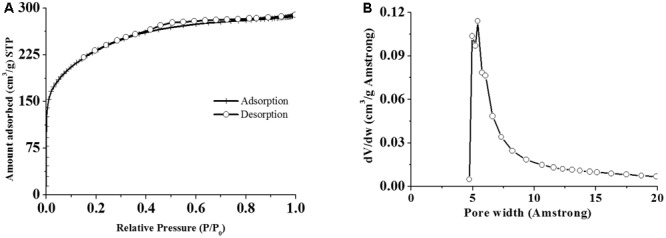
Determination of (A) specific surface area and (B) pore width of AC of J. curcas (ACJC) by BET analysis.